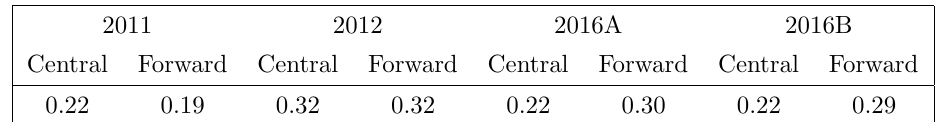
! (cid:22) + (cid:22) (cid:0) , B 0 ! (cid:22) + (cid:22) (cid:0) , the combinatorial background s